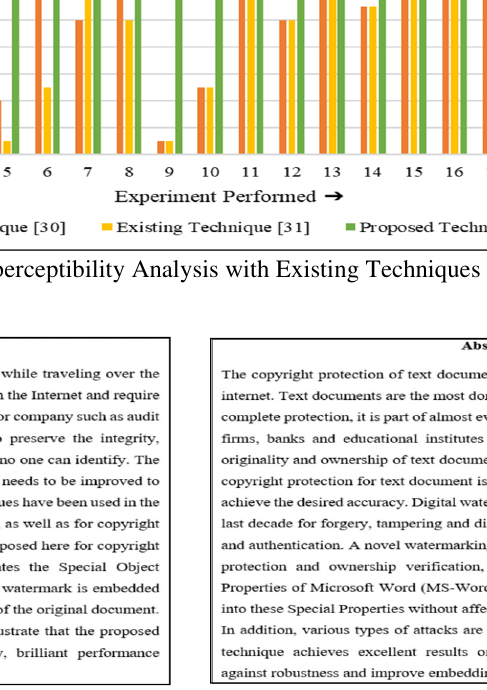
Fig. 7: Before Watermark Embedding on Right Side, After Watermark Embedding on Left Side